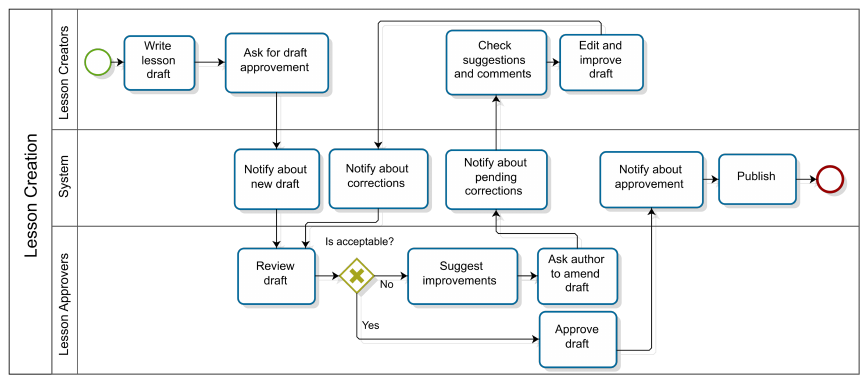
Figure 5. Proposal for the approval process for lessons